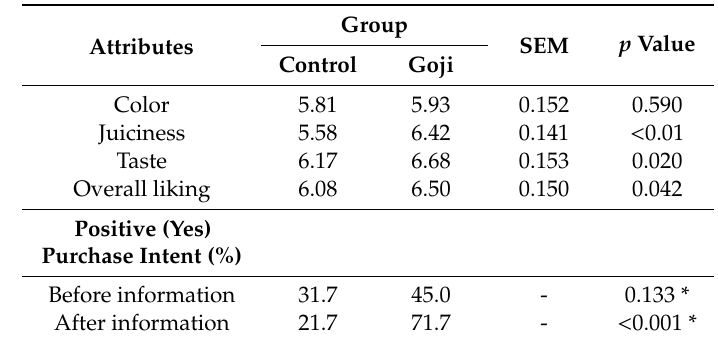
Table 3. Mean consumer scores for sensory acceptability and purchase intent of rabbit meat balls.